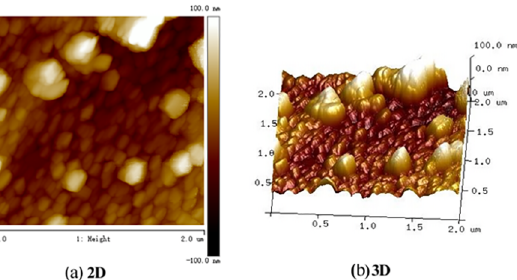
Figure 11 . 2D(a) and 3D(b) topographic AFM images of the corroded surfaces of the 440°C treated